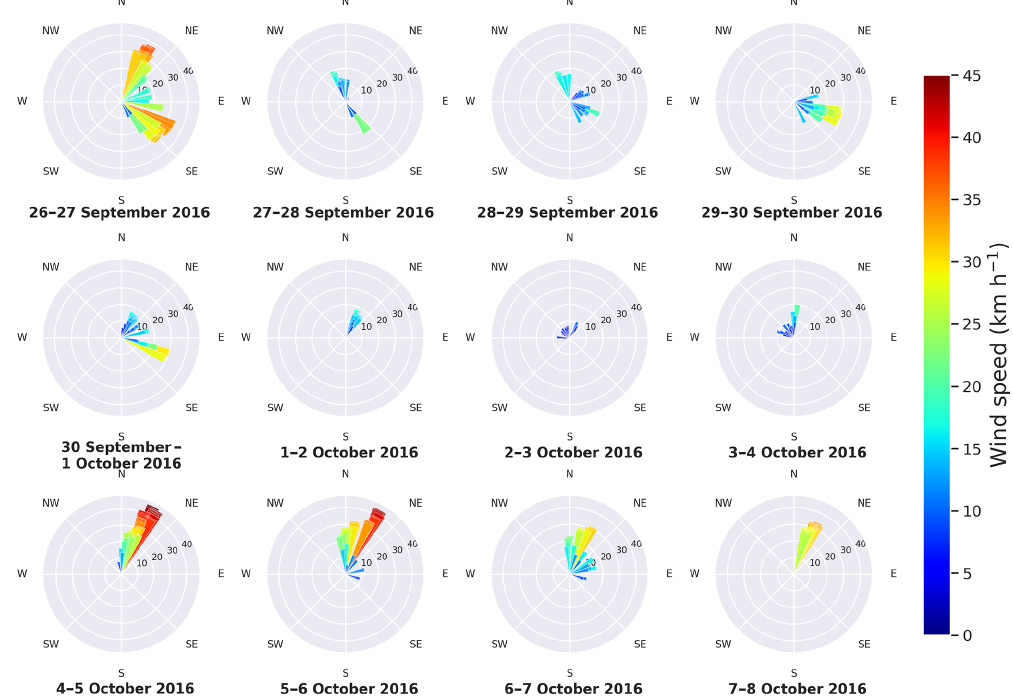
Figure 9. Maps of the 10m level wind vector (kmh − 1 ) from the ERA5 reanalysis. Each panel has vectors from the four grid points sur- rounding the locations of ice floe no. 2 and no. 3 every 3h during the time between the daily overpasses of Sentinel-1. For example, the 26–27 September panel shows the 3h vectors that were available between the period that spans the satellite acquisition times of 26 and 27 September.